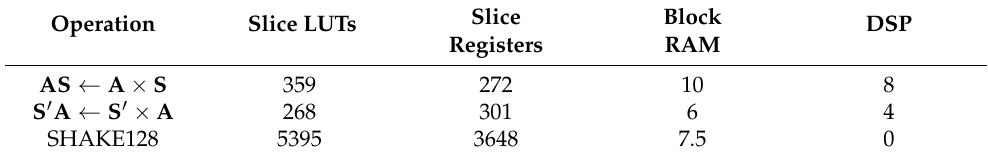
Table 2. Hardware resource